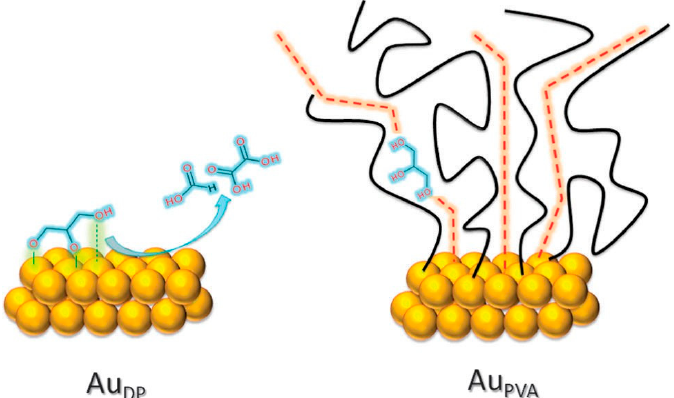
Figure 9. Model for glycerol adsorption on the surface of naked (left) and protected (right) gold NPs Reproduced from ref. [65] with permission of The Royal Society of Chemistry.